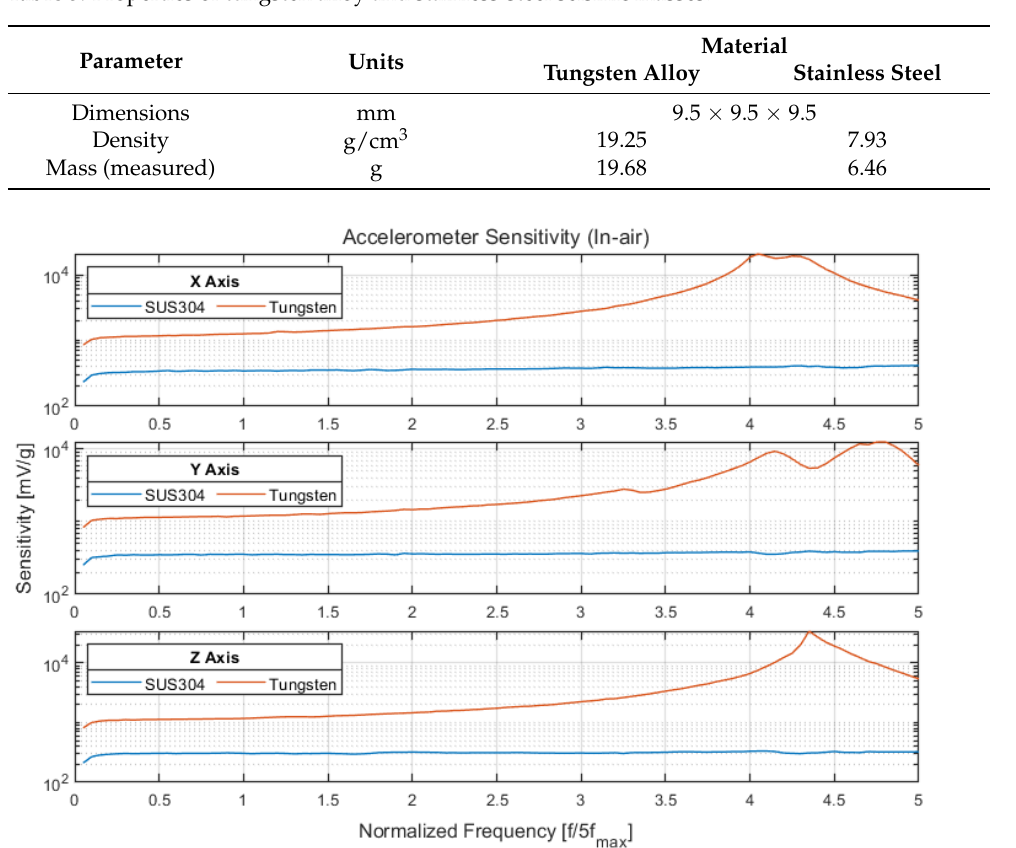
Table 5. Properties of tungsten alloy and stainless-steel seismic masses.